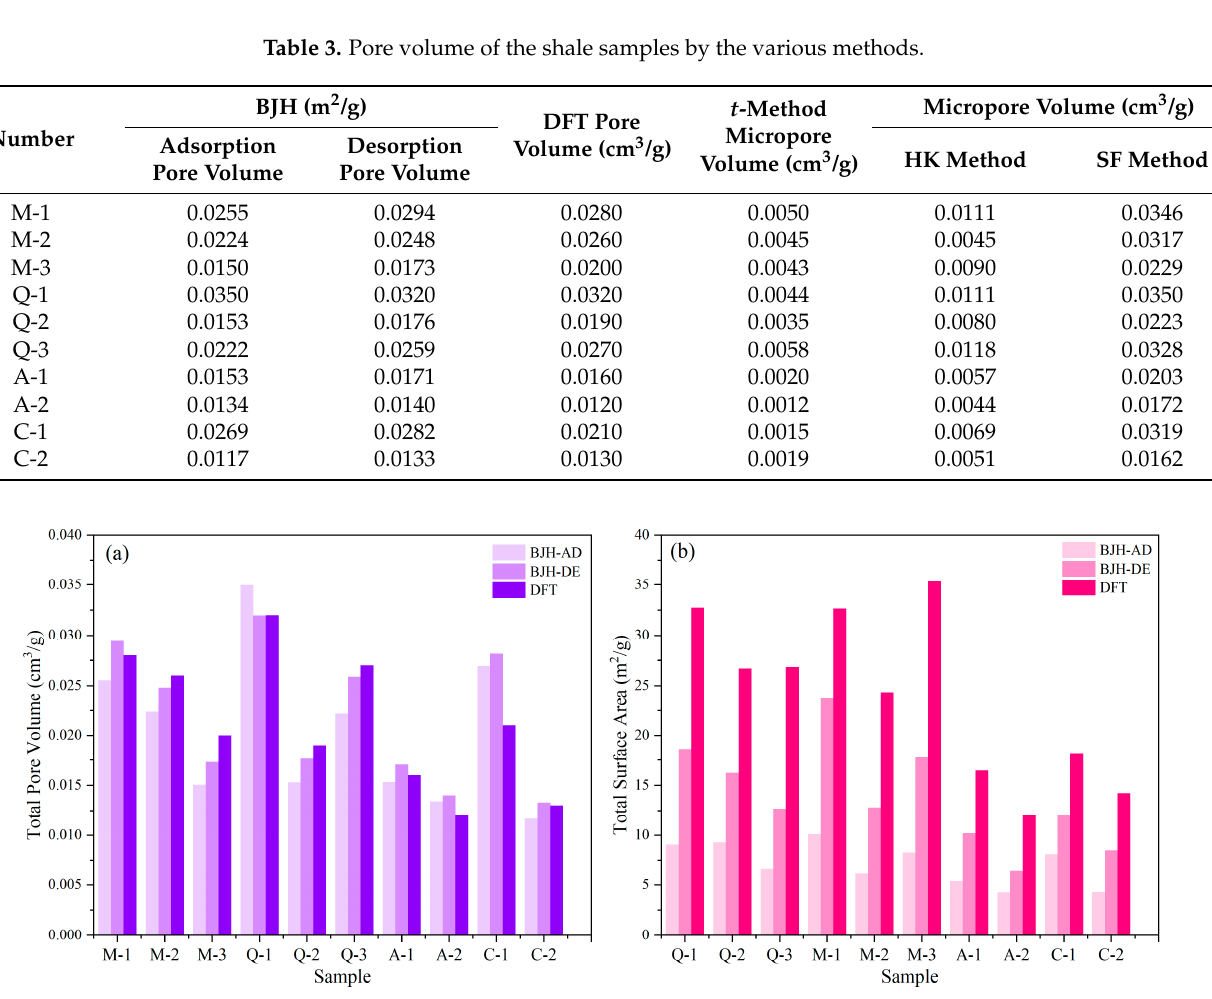
Figure 5. The total pore volumes ( a ) and surface area ( b ) of different N 2 adsorption model pores for the studied samples.